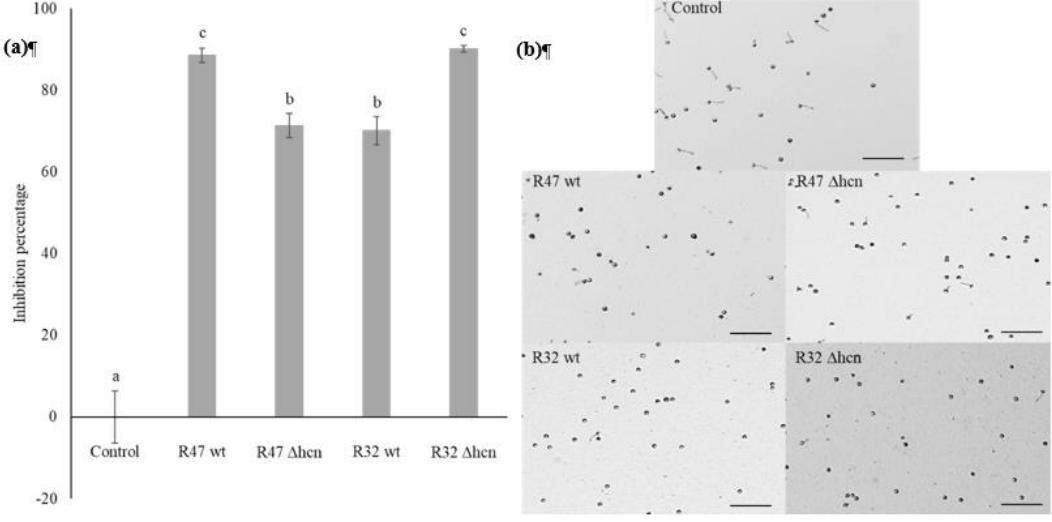
Figure 2. Effect of R47 (wt and ∆hcn) and R32 (wt and ∆hcn) strains on zoospore germination. ( a ) Graph representing the inhibition percentages of germinated zoospores when exposed to different strains and control (unexposed to bacterial strains). The bars show averages (n = 3 independent assays with 3–4 technical replicates) with error bars indicating standard error of the mean. Letters indicate significant differences between treatments as per ANOVA followed by Tukey’s HSD (threshold p < 0.05). ( b ) Representative images of zoospores after 3 h incubation with or without bacterial strains at room temperature. Scale bar = 100 μm.